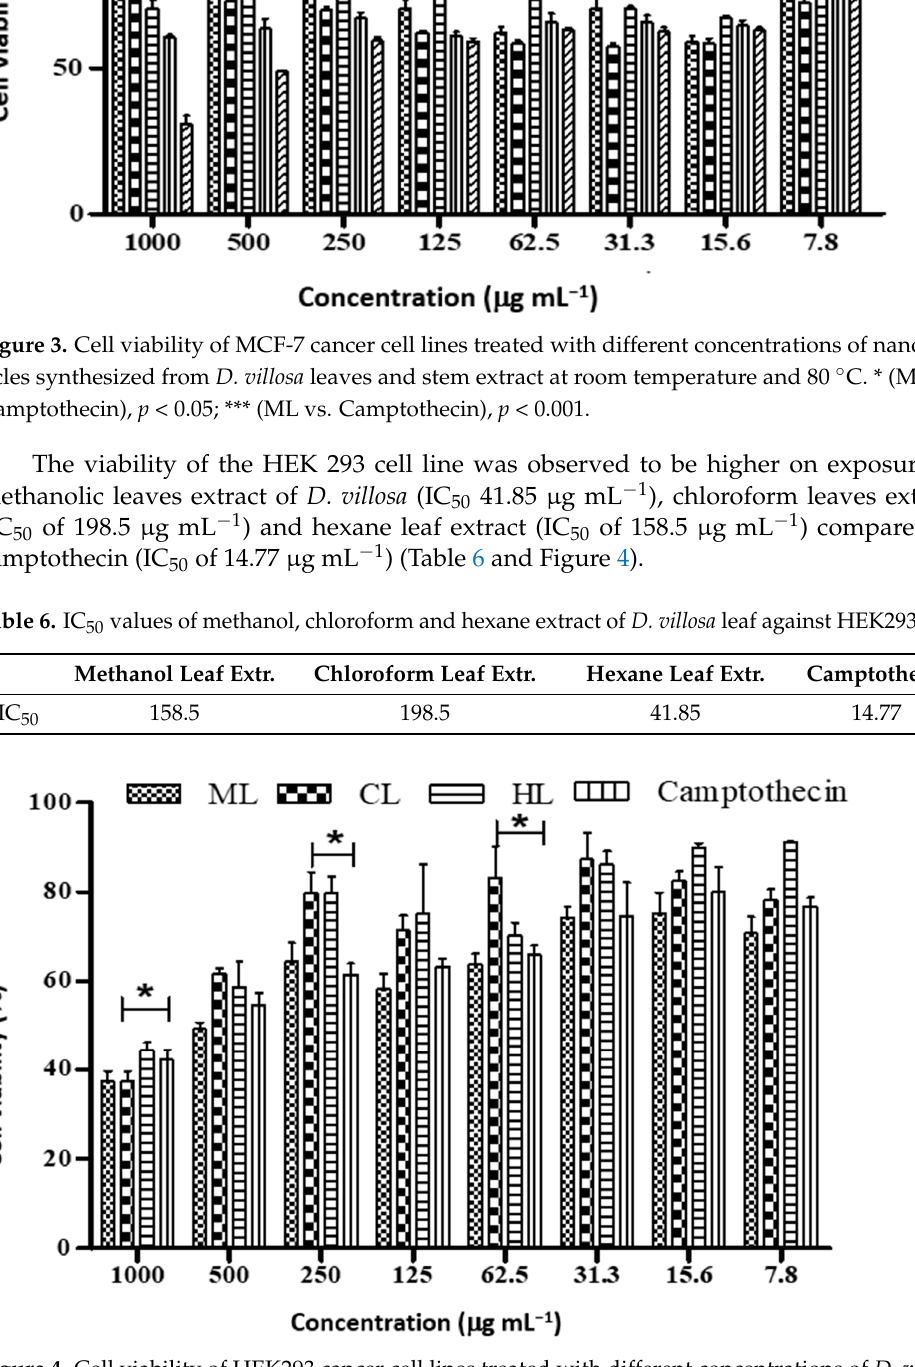
The viability of HEK293 cells was further observed to be greater when exposed to hexane stem extract of D. villosa (IC 50 of 45.13 µg mL − 1 ) (Figure 5). However, the viability of the HEK293 cells was largely affected when treated with the chloroform (IC 50 of 3.93 µg mL − 1 ) and methanolic (IC 50 of 0.10 µg mL − 1 ) extracts of D. villosa (Figure 5). Camptothecin produced an IC 50 of 14.77 µg mL − 1 (Table 7). Figure 5. Cell viability of HEK293 cancer cell lines treated with different concentrations of D. villosa stem extract.